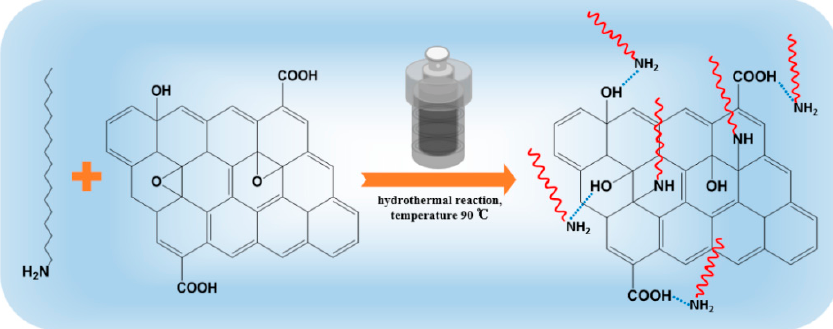
Figure 1. The fabrication process and mechanism of ODA@GO.